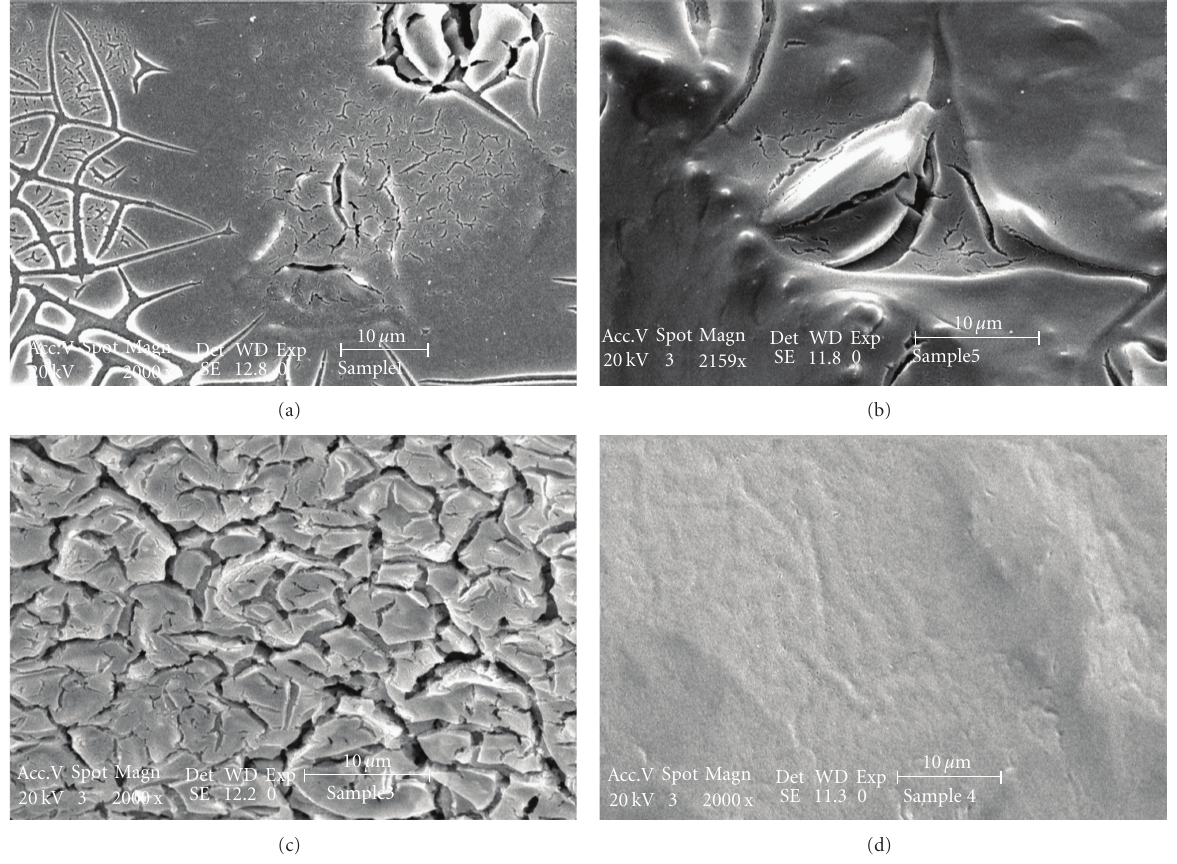
Figure 9: SEM images of freshly prepared (a) Ti / SnO 2 -Sb(2%), (b) Ti / SnO 2 -Sb(2%)-Ni(0.2%), (c) Ti / SnO 2 -Sb(2%)-Ni(1%), and (d) Ti / SnO 2 -Sb(12%)-Ni(0.2%) electrodes. The values in parentheses are atomic ratios with respect to Sn. coworkers obtained by 4-probe resistivity meter [32] and describes lower capacitance of the electrodes with higher Ni content (Section